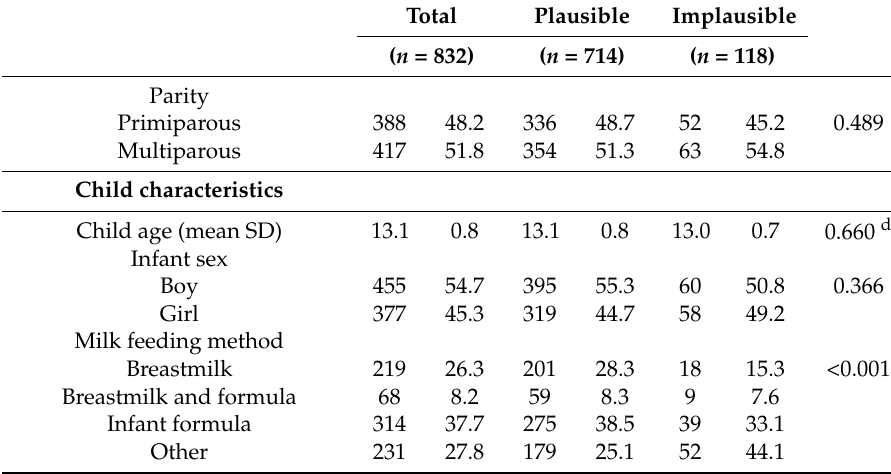
Figure 2. Frequency of intake of zinc ( n = 714) showing estimated average requirement (EAR = 2.5 mg) and upper limit of intake (UL = 7 mg). 3.2.2. Comparison of Nutrient Intakes by Milk Feeding Method The majority of all 832 children were still receiving breastmilk ( n = 334, 36%) and/or formula ( n = 374, 53%); only 26 children (4%) were consuming toddler formula. Of those with plausible energy intakes, 260 children (36%) were consuming breastmilk and 334 children (47%) were consuming formula. Children were categorized according to whether or not they consumed breastmilk and/or formula and the mean intakes of energy, macronutrients and those micronutrient for which more than 10% of children had inadequate or excessive intakes were compared (Table 3). There were a number of significant between ‐ group differences for all nutrients but in general children who did not drink either breastmilk and/or formula had significantly higher intakes of energy, protein, sodium,